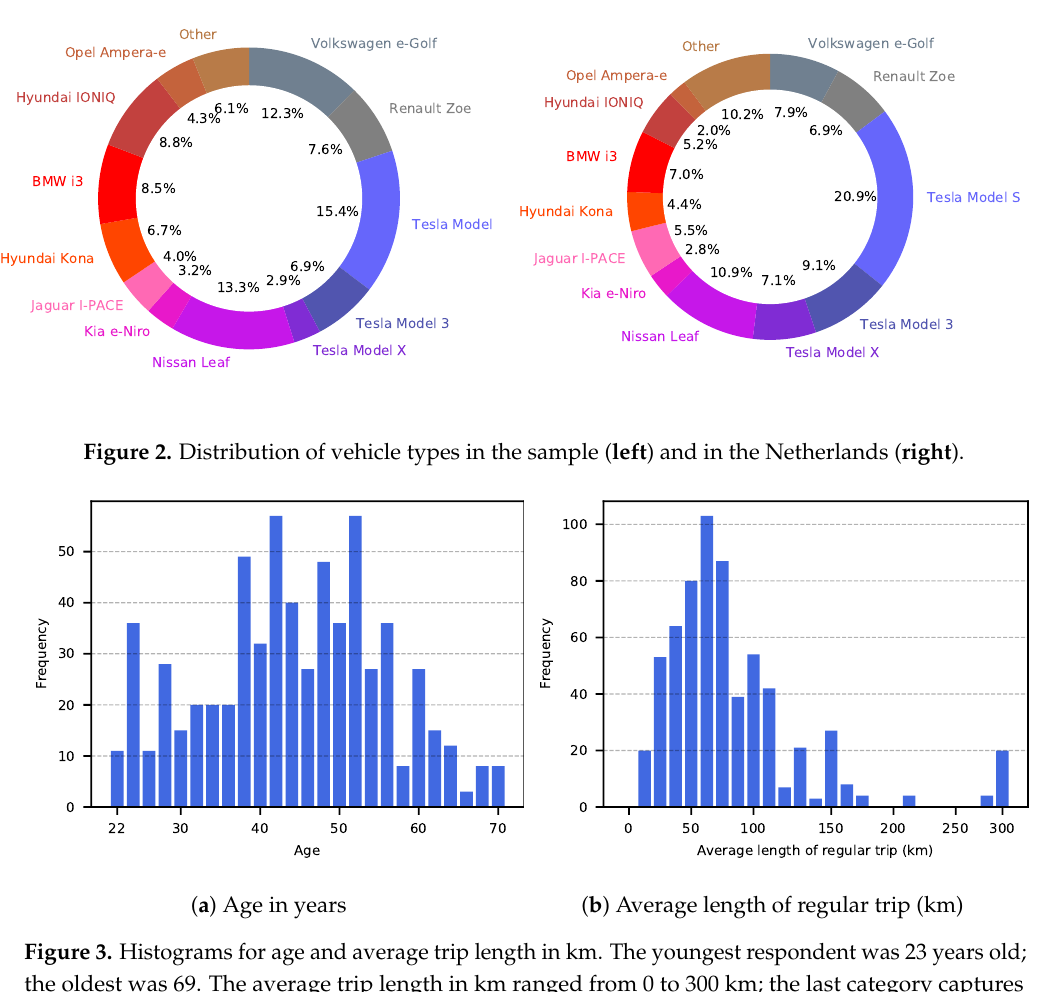
Figure 3. Histograms for age and average trip length in km. The youngest respondent was 23 years old; the oldest was 69. The average trip length in km ranged from 0 to 300 km; the last category captures respondents who answered 300 km or